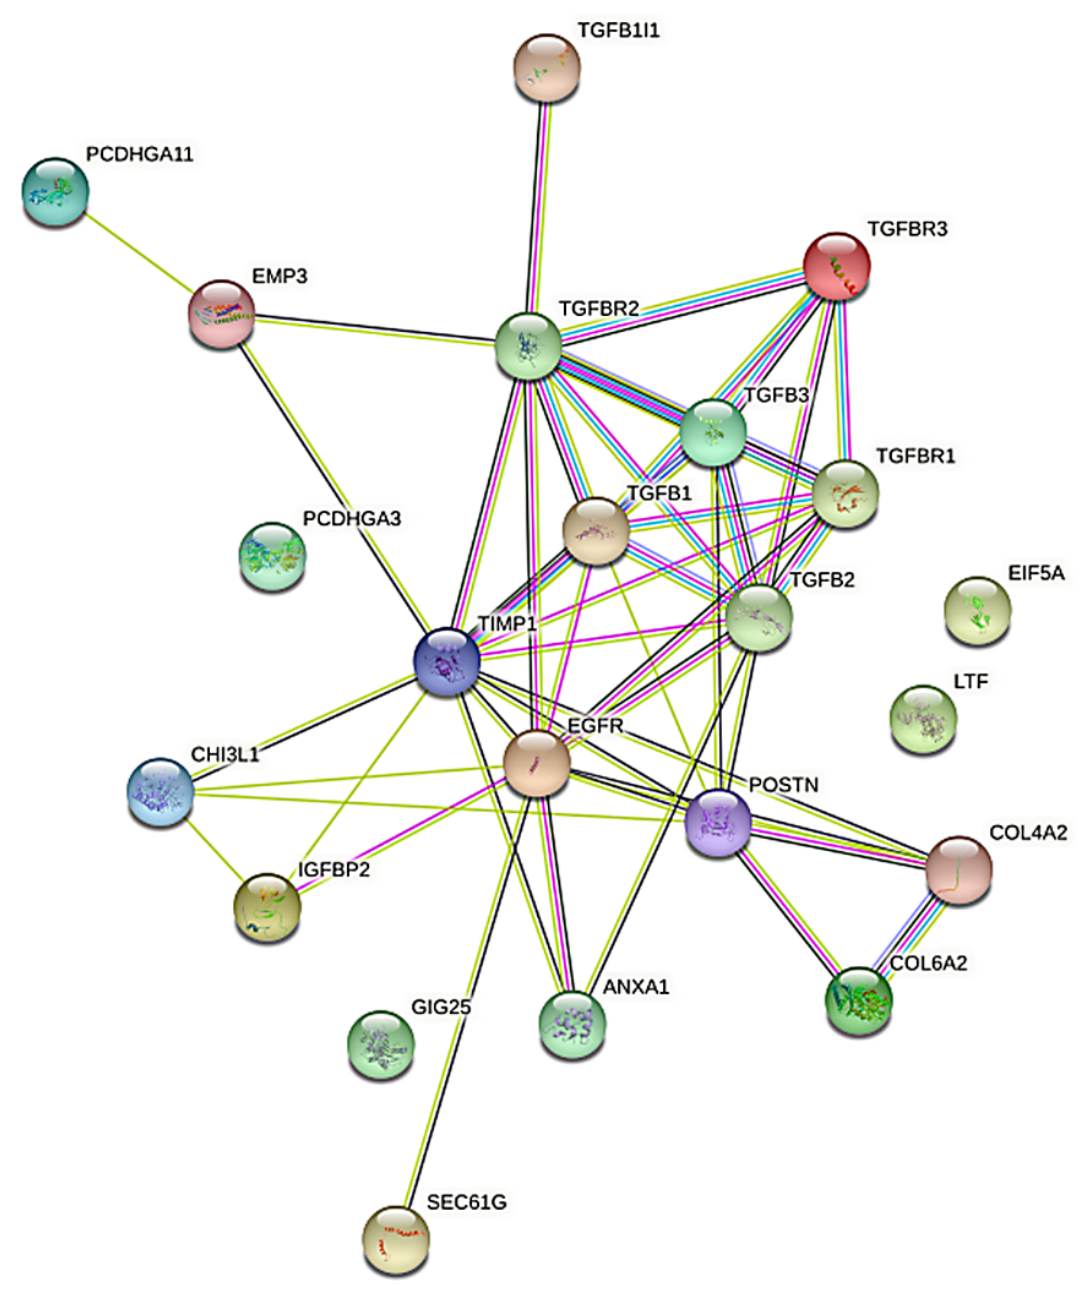
Figure 5. Protein–protein interaction network generated in the STRING database. STRING database—Search Tool for the Retrieval of Interacting Genes/Proteins. Table 5. Selected signaling pathways and biological processes in which specific differential genes play an important